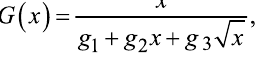
spond to small oscillation amplitudes, as depicted from Figure